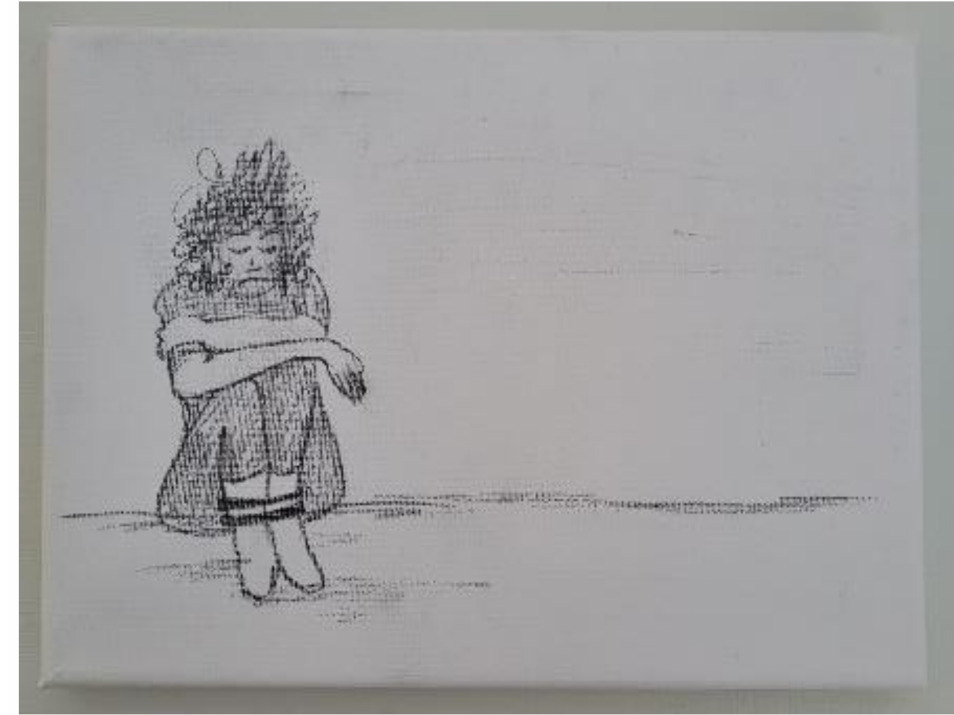
Figure 2. Leora’s drawing of a girl bound and alone.